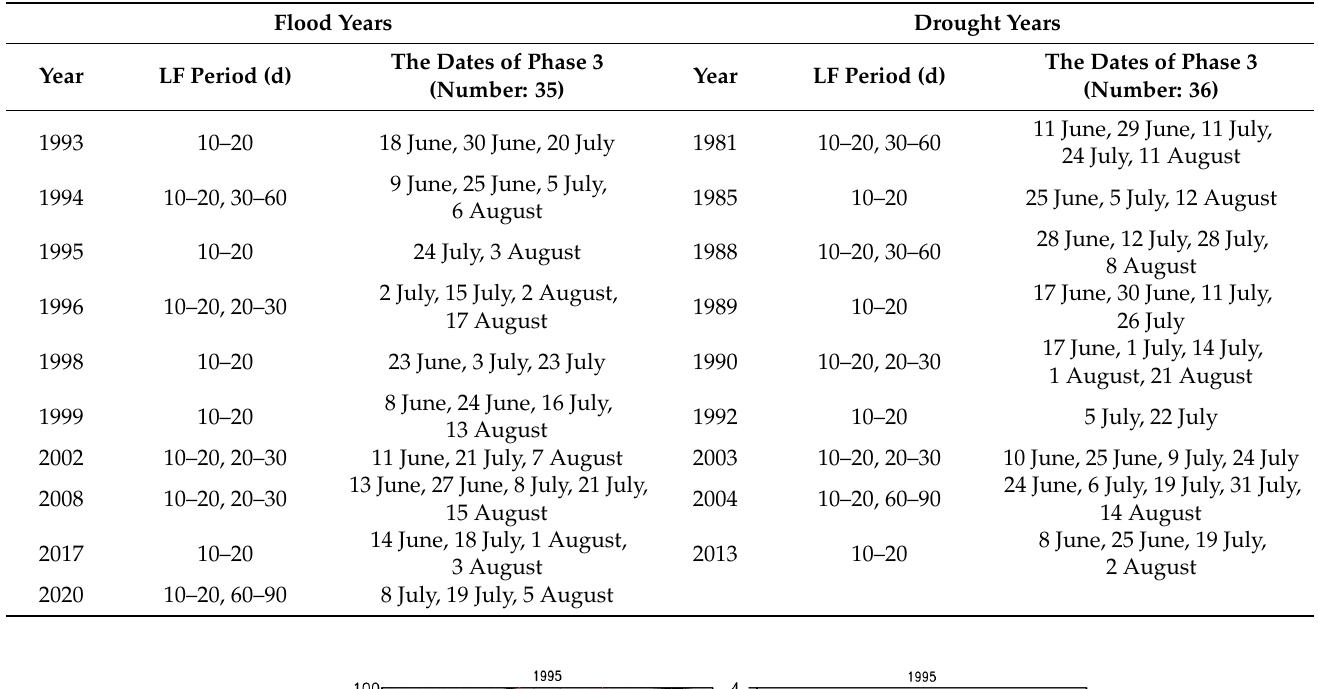
Table 1. The significant low-frequency (LF) period (significant at α = 0.05 level) and the calendar dates of phase 3 in each year of flood and drought years.